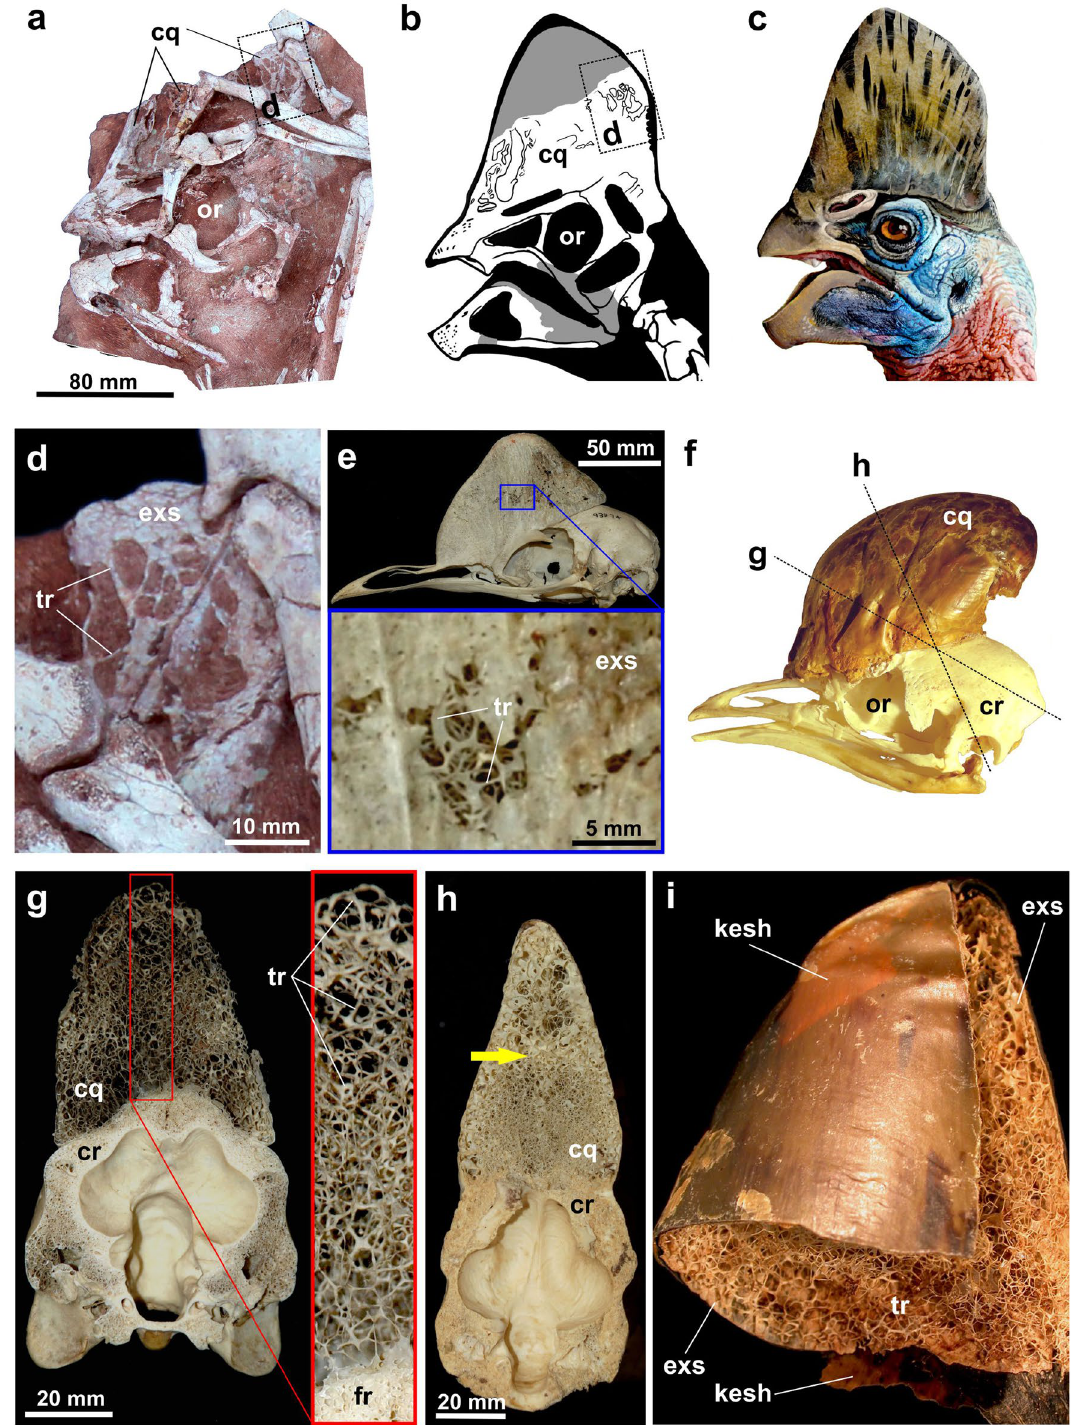
Figure 2. The cranial casque of Corythoraptor jacobsi and recent cassowaries. ( a – c ) the crested skull of Corythoraptor and head appearance restorations. ( d ) a close-up (see dotted rectangle in a and b ) of eroded bony shell in the posterolateral casque of Corythoraptor . ( e ) the crested skull of the recent cassowary ( Casuarius uniappendiculatus ; Museum für Naturkunde in Berlin, Germany: MfN-ZMB 93274). ( f ) a keratinous helmet over the skull of the recent cassowary (unnumbered specimen of Casuarius casuarius from the osteological collections of ZOO Protivín, Czech Republic). ( g , h ) coronal cuts through the cassowary skull – ( g ) Casuarius casuarius MfN-ZMB 36820, ( h ) Casuarius casuarius : MfN-ZMB 36885 (see dotted lines in f ); note transition in strut-like trabecular arrangement. ( i ) close-up to contact between keratinous and skeletal components of the casque in recent cassowary, unnumbered specimen of Casuarius sp. from the osteological collections of Field Museum of Natural History, Chicago, USA. Abbreviations: cq, casque; cr, cranium; exs, external surface; kesh, keratinous sheath; or, orbit; tr,